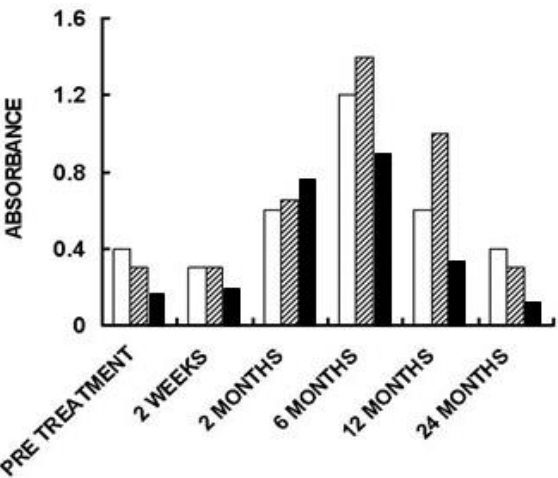
Figure 6. Anti-non gal IgG antibody response in three of the patients implanted with processed porcine BTB bioprosthesis for the reconstruction of torn ACL. Anti-non gal antibody activity at various time-points post-implantation was determined with anti-Gal depleted sera, by ELISA. Homogenate of fragmented porcine tendon was used as solid-phase antigen. The figure describes antibody binding at serum dilution of 1:640 (based on data from [71]).